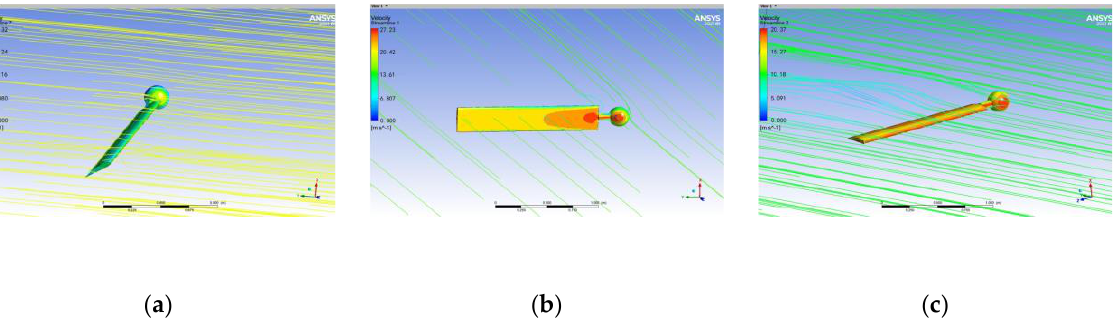
Figure 11. Fluent simulation process: ( a ) synchronous deployment process; ( b ) non-fixed-axis – fixed- axis stepwise deployment process; ( c ) fixed-axis – non-fixed-axis stepwise deployment process.